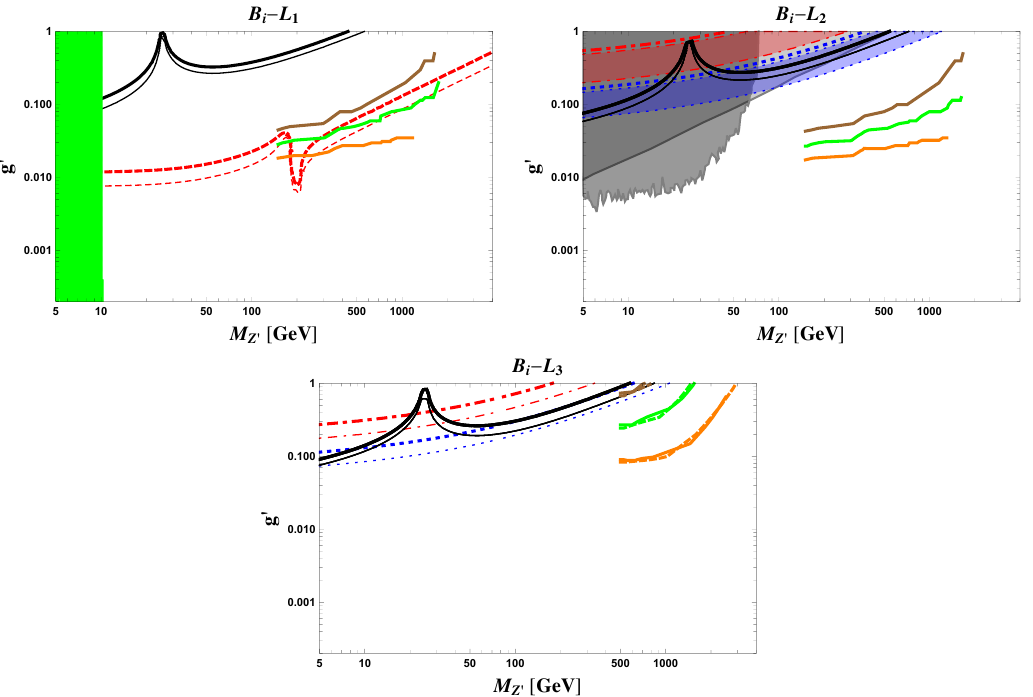
Figure 2 . Bounds on g 0 and M Z 0 for the B i (cid:0) L j models. The green region is excluded by BaBar bounds [19]. The solid(dashed)-orange, -green, and -brown curves correspond to the ATLAS (CMS) bounds for B 1 , B 2 , and B 3 , respectively. Note that we considered only the bottom quark in the B 3 case. The lighter- and darker-grey regions are excluded by neutrino-trident bound [26, 27] and the LHC bound for Z ! 4 (cid:22) [28]. Upper left panel : bounds on g 0 and M Z 0 for the B i (cid:0) L 1 models. The thin (thick) dashed-red and solid-black curves correspond to 1 (cid:27) (2 (cid:27) ) bounds from LEP search [18] and SLD/LEP Z -decay lepton universality test [15], respectively. Upper right panel : bounds on g 0 and M Z 0 for the B i (cid:0) L 2 models. The thin (thick) solid-black curve corresponds to 1 (cid:27) (2 (cid:27) ) bounds from the SLD/LEP Z -decay lepton universality test [15]. The blue (red) shaded region between thin dotted-blue (dot-dashed-red) curves is the 1 (cid:27) -allowed region by HFAG lepton universality test [16] for the B 1 ( B 2 ) case. The corresponding 2 (cid:27) -allowed region is below the thick dotted-blue (dot- dashed-red) curve. Lower panel : bounds on g 0 and M Z 0 for the B i (cid:0) L 3 models. The thin (thick) solid-black curve corresponds to 1 (cid:27) (2 (cid:27) ) bound from the SLD/LEP Z -decay lepton universality test [15]. The thin (thick) dot-dashed-red, dotted-blue curves correspond to 1 (cid:27) (2 (cid:27) ) bounds from the HFAG lepton universality test [16] for the B 2 and B 1 cases,